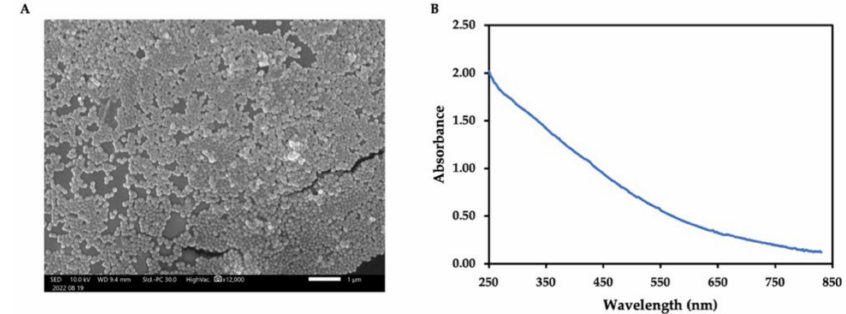
Figure 1. ( A ) SEM image and ( B ) UV-Vis spectrum of synthesized PDA-NPs.